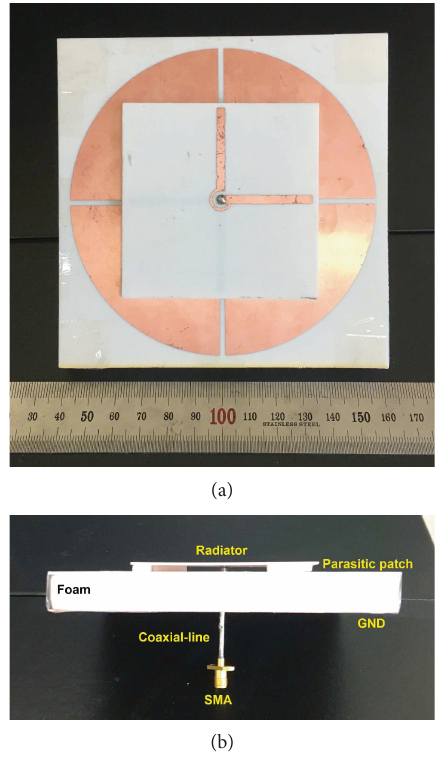
Figure 12: Fabricated sample of the crossed-dipole antenna loaded with parasitic patches: (a) top view and (b) side